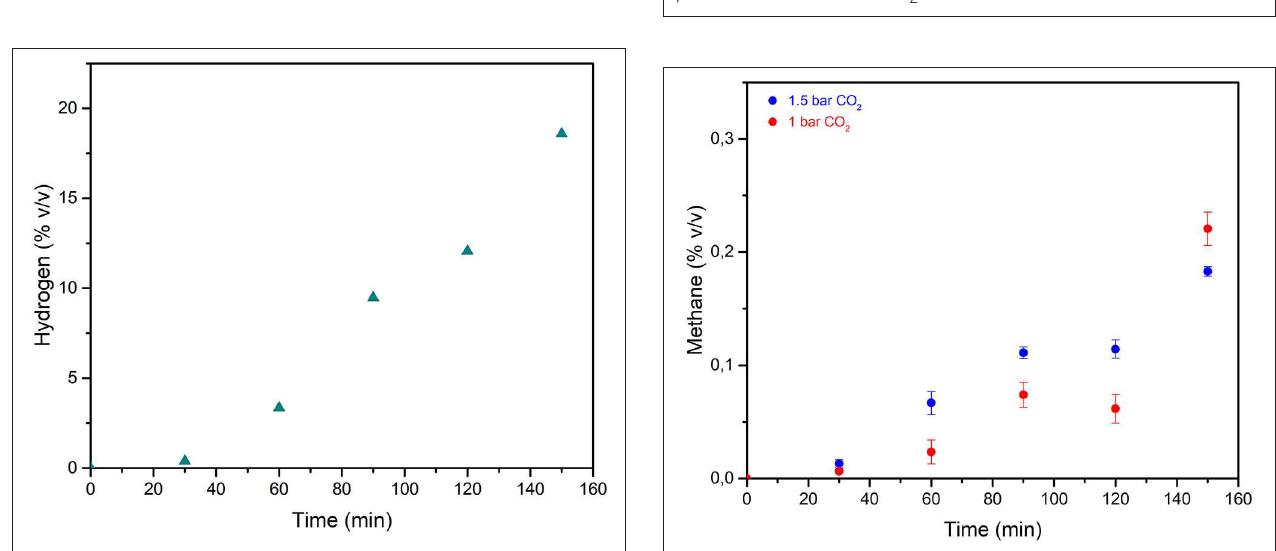
FIGURE 8 | Methane concentration data relevant to the three different test series. Blue dots: initial CO 2 pressure equal to 1.5 bar. Red dots: initial CO 2 pressure equal to 1.0 bar. The data are replicates of two runs and error bars refers to standard deviation